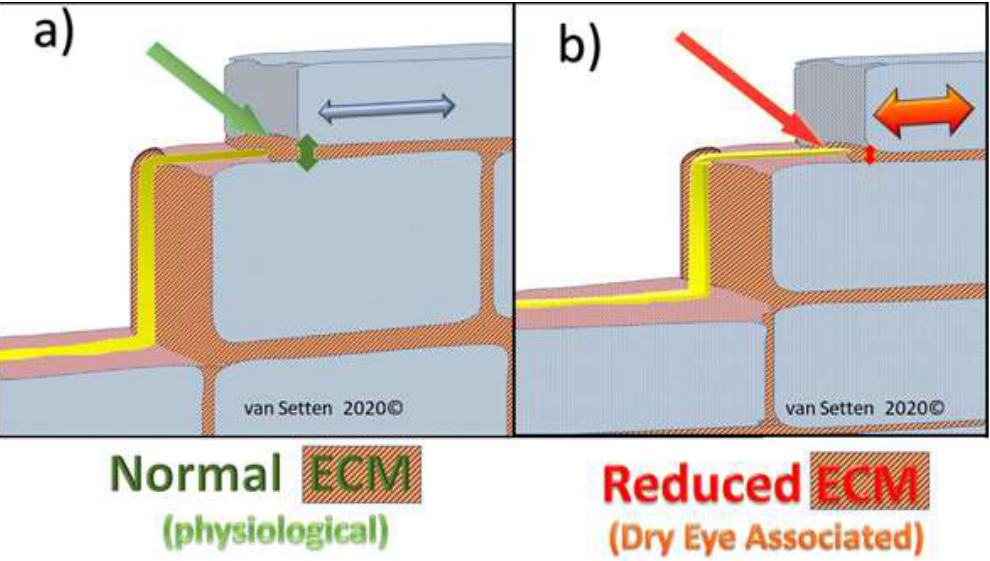
Figure 5. ( a ) Shows, schematically, in a model, how nociceptive nerves in the epithelium pass through the intercellular space, which is maintained with good elasticity and resilience. With decreased ECM, Figure 5 ( b ), intercellular spacing is reduced and mechano-transduction without normal dissipation could lead to enhanced shear and friction, squeezing the axons causing them to fire by every movement of the eye or lid, creating sensation of pain and